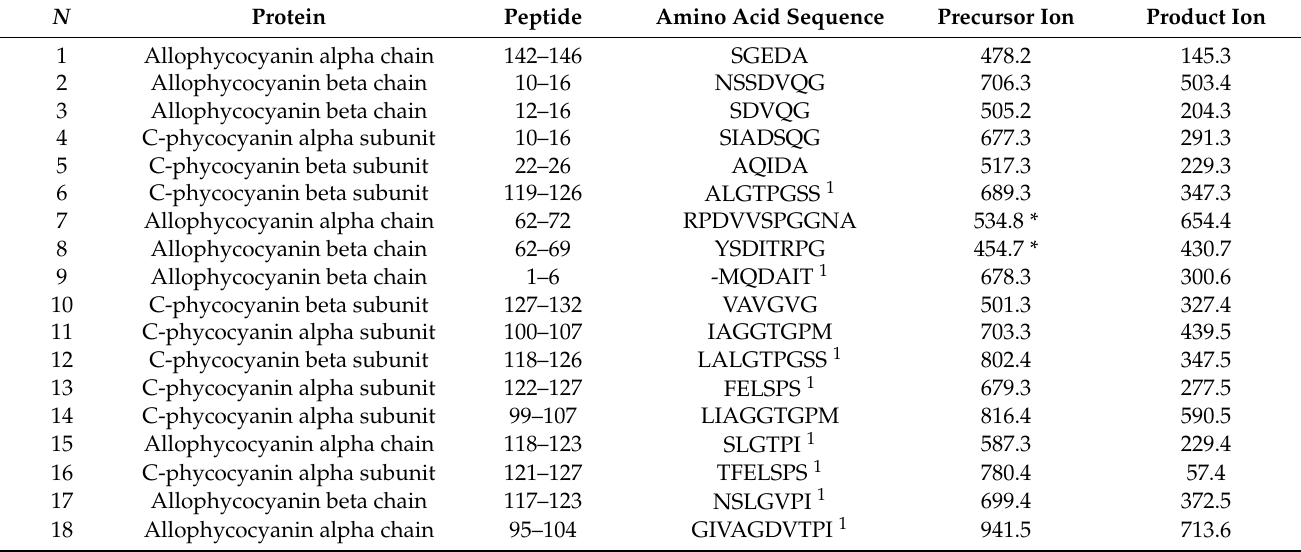
Table 1. Peptides from different proteins of Arthrospira platensis selected for the quantitative mass spectrometry-based method. Monitored m / z of parent and fragment ions are